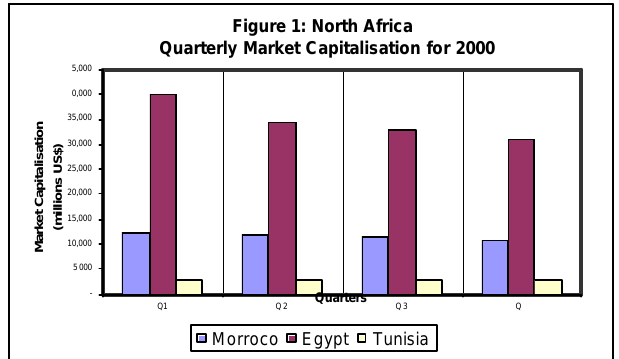
Figure 1: North Africa Quarterly Market Capitalisation for 2000